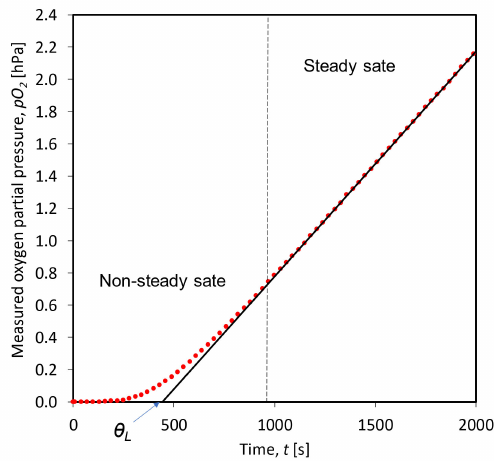
Figure 1. A plot of oxygen partial increment versus time in the oxygen-free